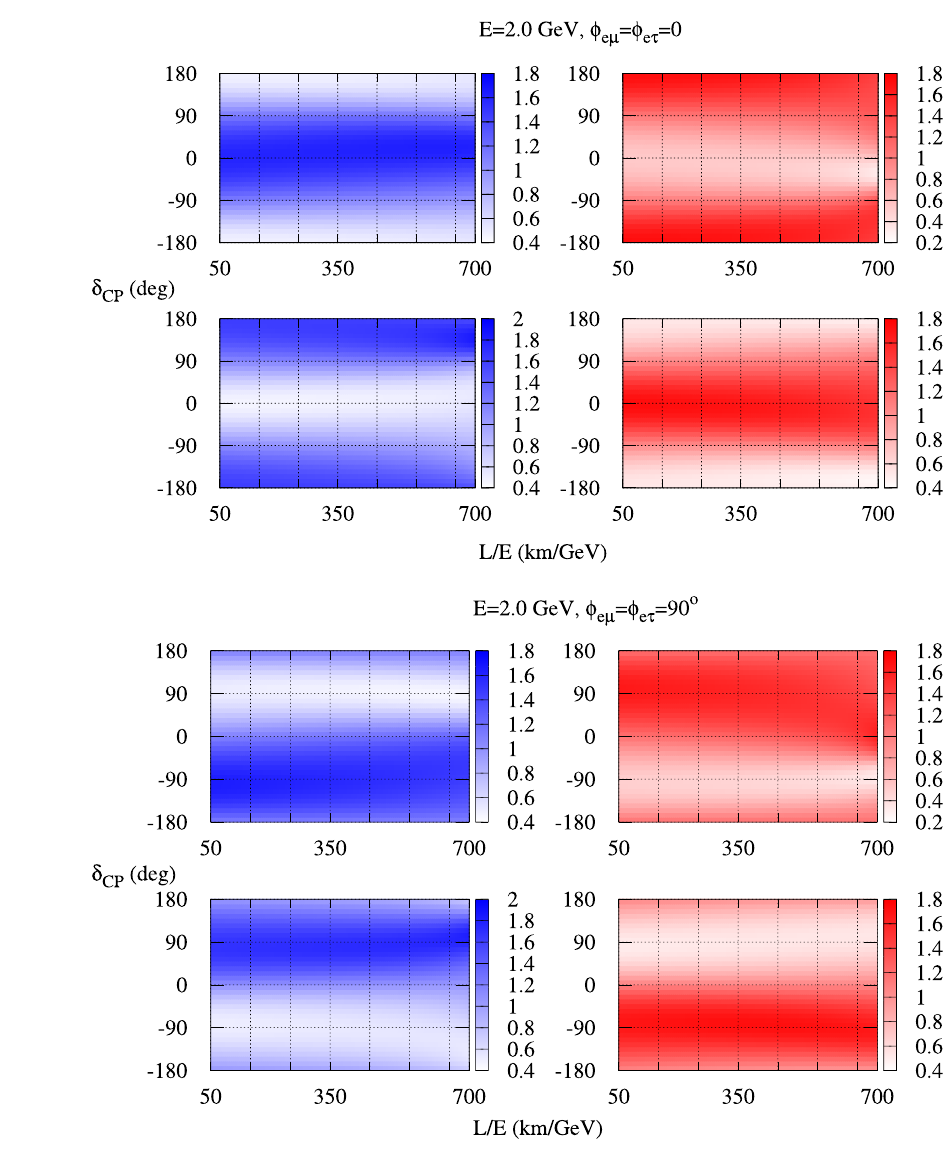
Fig. 4 Ratio of the LIV to standard oscillation probabilities as a function of L / E and δ CP